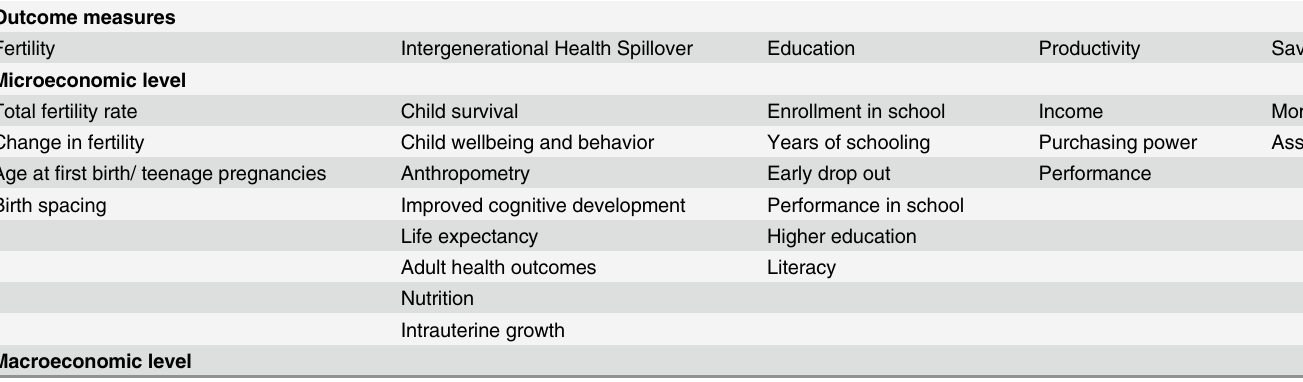
Table 1. Outcome measures by